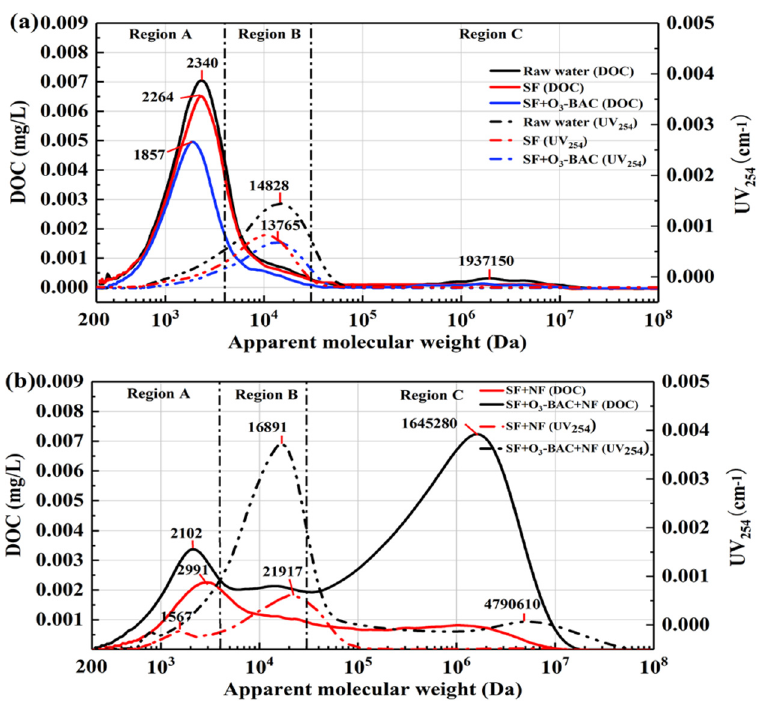
Figure 3. Molecular weight distribution by HPSEC for: ( a ) SF and SF+O 3 -BAC pre-treated water, and ( b ) NF washing solutions (after 30 days of operation).